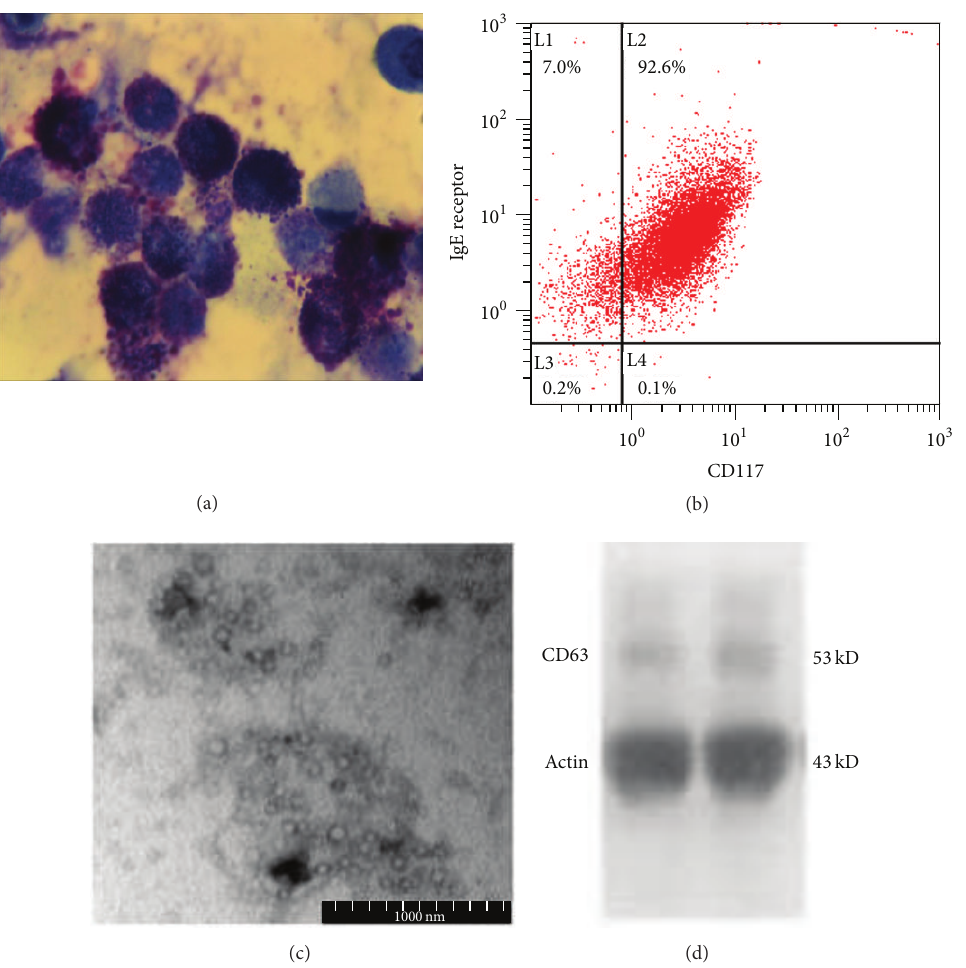
Figure 2: Characteristics of bone marrow mast cells and their exosomes. (a) Bone marrow mast cells showed abundant purple granules following toluidine blue staining (400x). (b) Mast cells were positive for CD117 and IgE receptor (Fc 𝜀 RI) by flow cytometry analysis. (c) BMMC-exosomes displayed a cup-shape morphology; scale bar = 100nm. (d) Western blot indicated that BMMC-exosomes expressed CD63, a marker constitutively expressed by